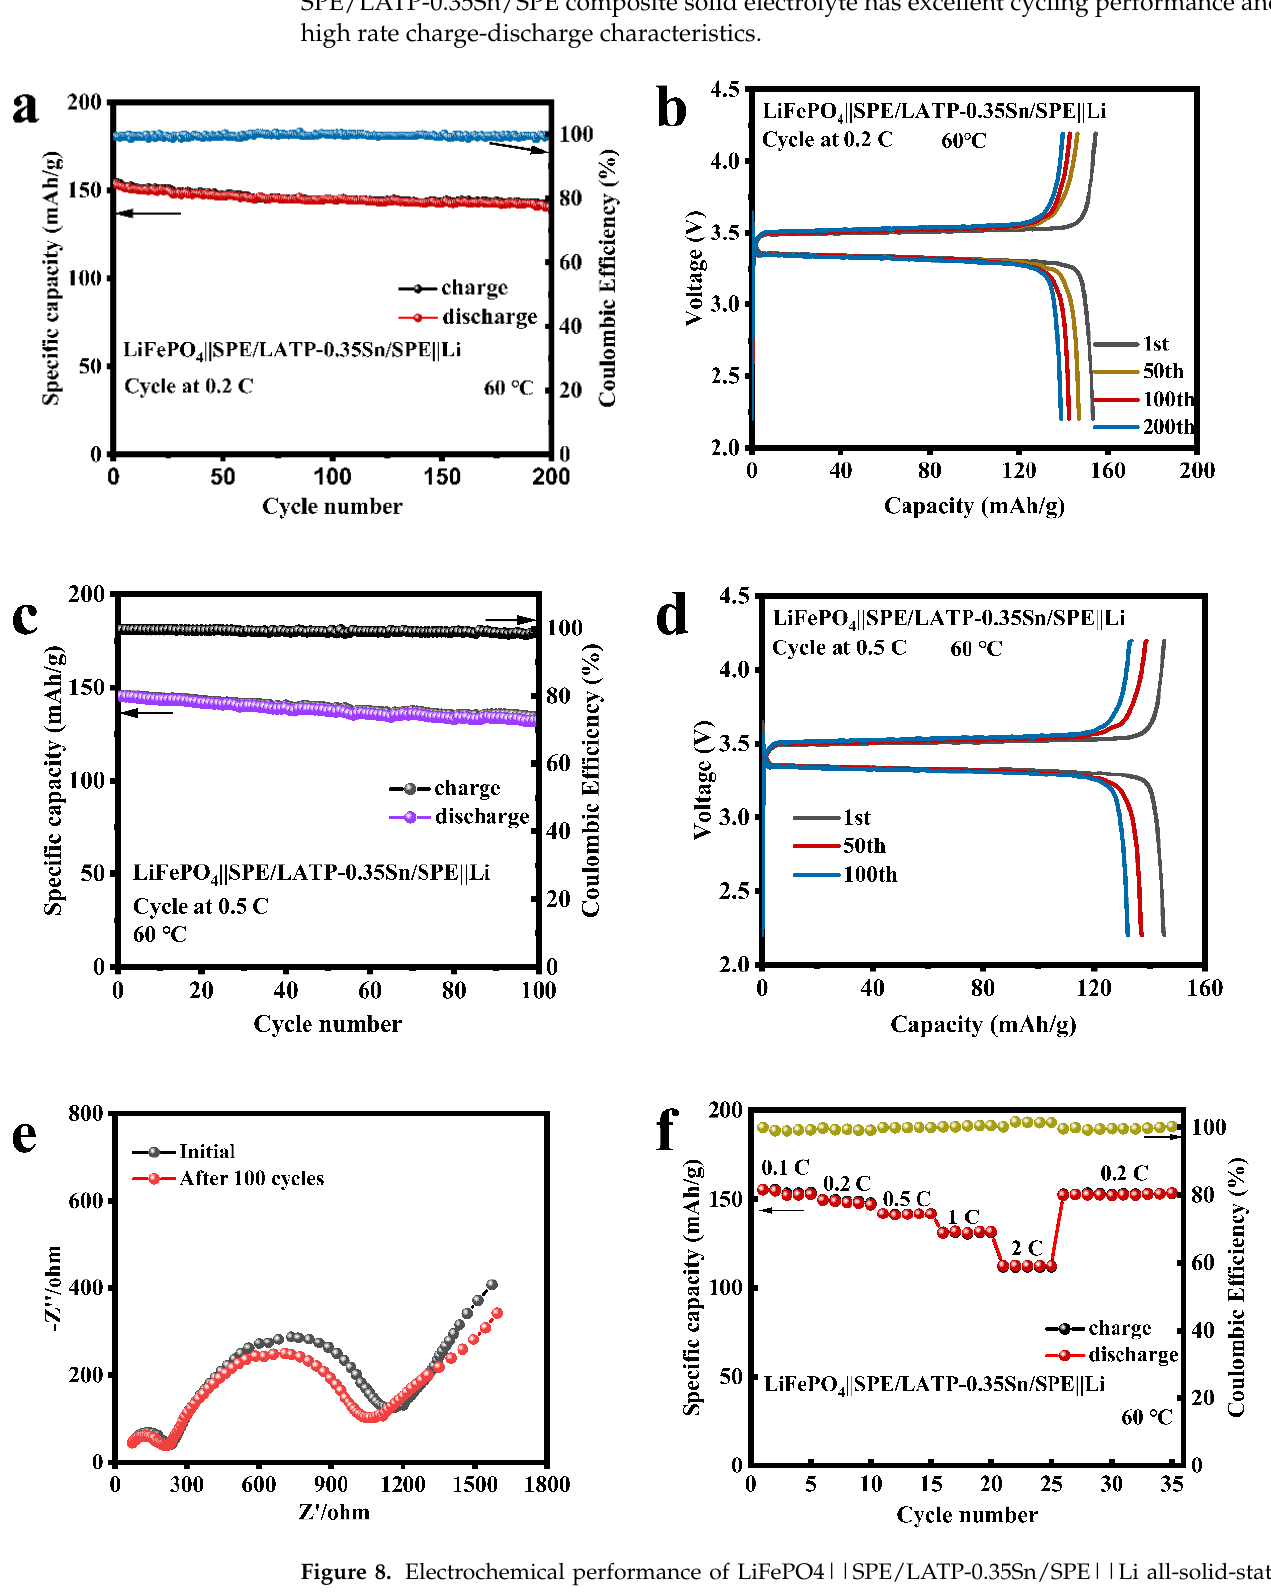
Figure 8. Electrochemical performance of LiFePO4||SPE/LATP-0.35Sn/SPE||Li all-solid-state lithium battery: ( a ) cycle performance at 0.2 C; ( b ) charge-discharge curves at 0.2 C; ( c ) cycle performance at 0.5 C; ( d ) charge-discharge curves at 0.5 C; ( e ) Electrochemical impedance plots before and after cycling at a rate of 0.5 C; ( f ) rate performance at various rates ranging from 0.1 C to 2 C.